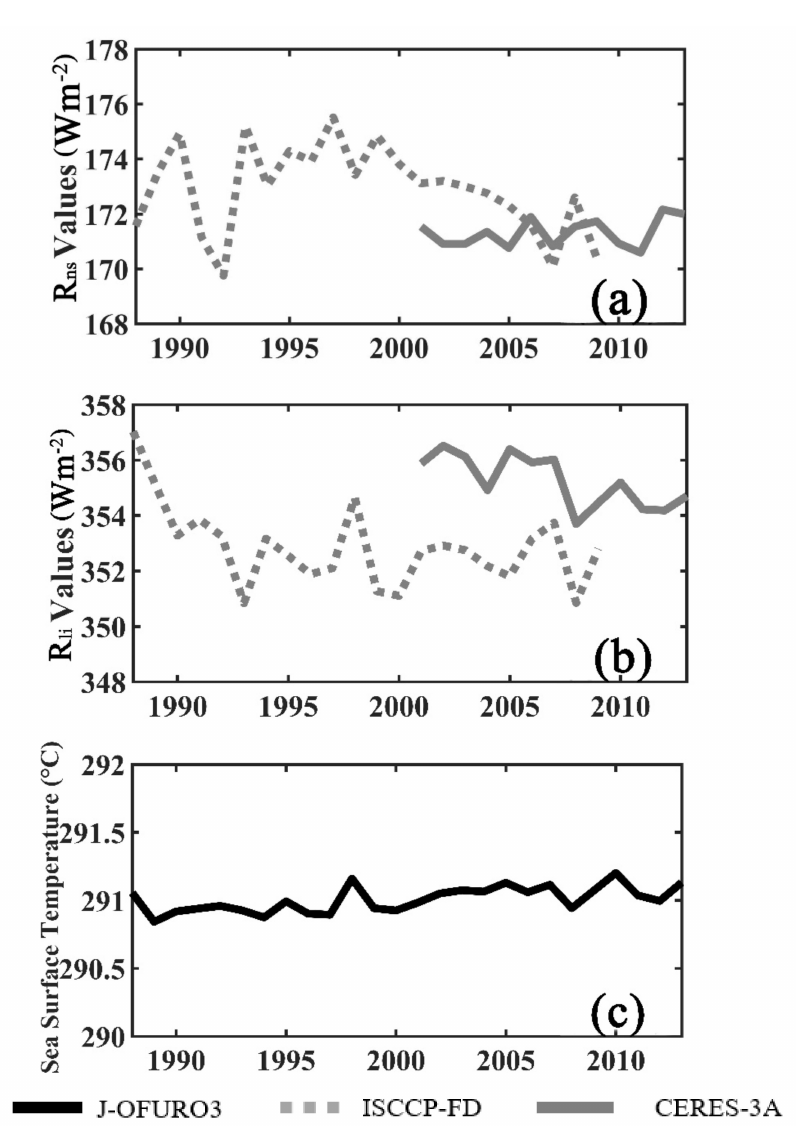
Figure 8. Interannual variations in the annual mean sea-surface ( a ) R ns , ( b ) R li , and ( c ) SST values from 1988 to 2013 in the J-OFURO3, ISCCP-FD, and CERES-3A datasets over the global ice-free oceans.